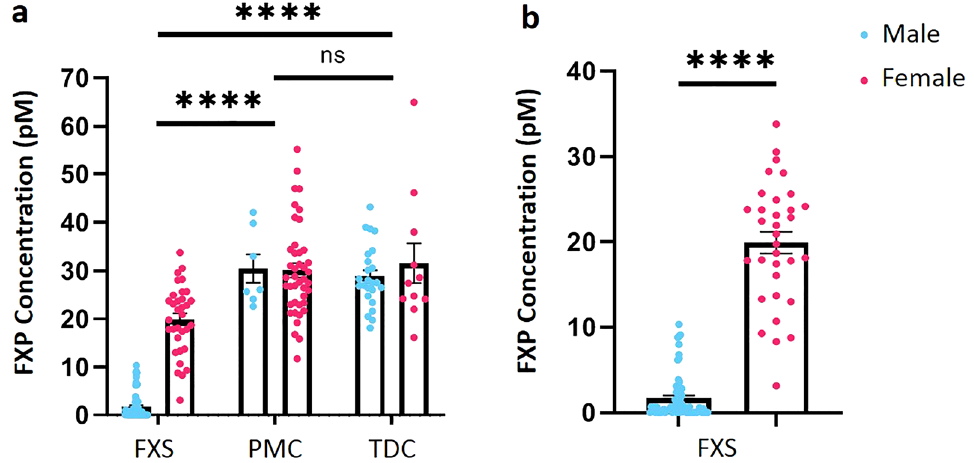
Figure 4. FXP concentration is reduced in peripheral blood of individuals with FXS. ( a ) FXP concentration in all individuals across diagnostic categories from DBS eluate. Graphically males and females are separated into individual bars; however, they were grouped as a diagnostic category when analyzed statistically. FXP concentration is significantly lower in the FXS diagnostic group than PMC and TDC diagnostic groups (Mixed-effects analysis with Šídák’s multiple comparisons test; main effect of diagnosis, p < 0.0001 F (1.900, 67.46) = 139.8; main effect of sex p < 0.0001 F (1, 110) = 21.67; interaction diagnosis x sex p < 0.0001, F (2, 71) = 27.30; p(FXS vs PMC) < 0.0001, p(FXS vs TDC) < 0.0001, p(PMC vs TDC) = 0.9882). ( b ) FXP expression is significantly lower in males with FXS than females with FXS (Mann–Whitney U = 20, n 1 = 70 n 2 = 33, p < 0.0001 two-tailed). There were no significant sex differences in FXP expression in PMC (Unpaired T Test, t(47) = 0.1016, p = 0.9195 two-tailed) or TDC (Mann–Whitney U = 130, n 1 = 34 n 2 = 11, p = 0.9582 two-tailed). Mean reported with error bars representing SEM. FXP Fragile X Protein, FXS Fragile X Syndrome, DBS Dried Blood Spot, PMC Premutation Carriers, TDC Typically Developing Controls, SEM Standard Error of the Mean, NS Not Significant, ****Indicates p <